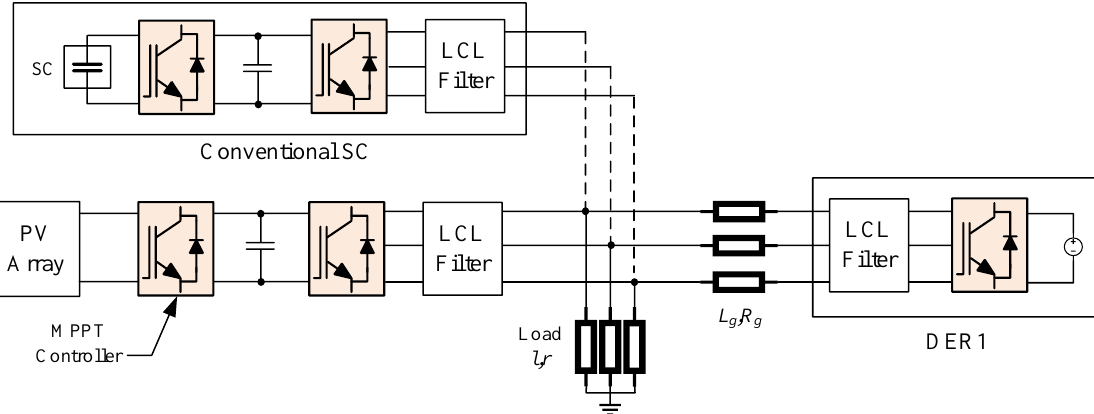
Figure 25. Islanded microgrid representation with the BPS and BPS-SC. The open dashed lines represent BPS, and the closed dashed lines represent BPS-SC.